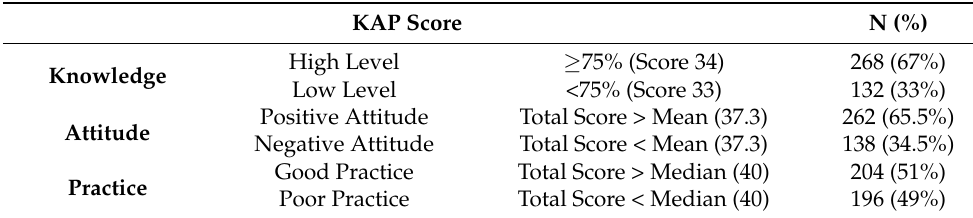
Table 3. Overall Knowledge, Attitude, and Practice (KAP) score: criteria for the categorization of